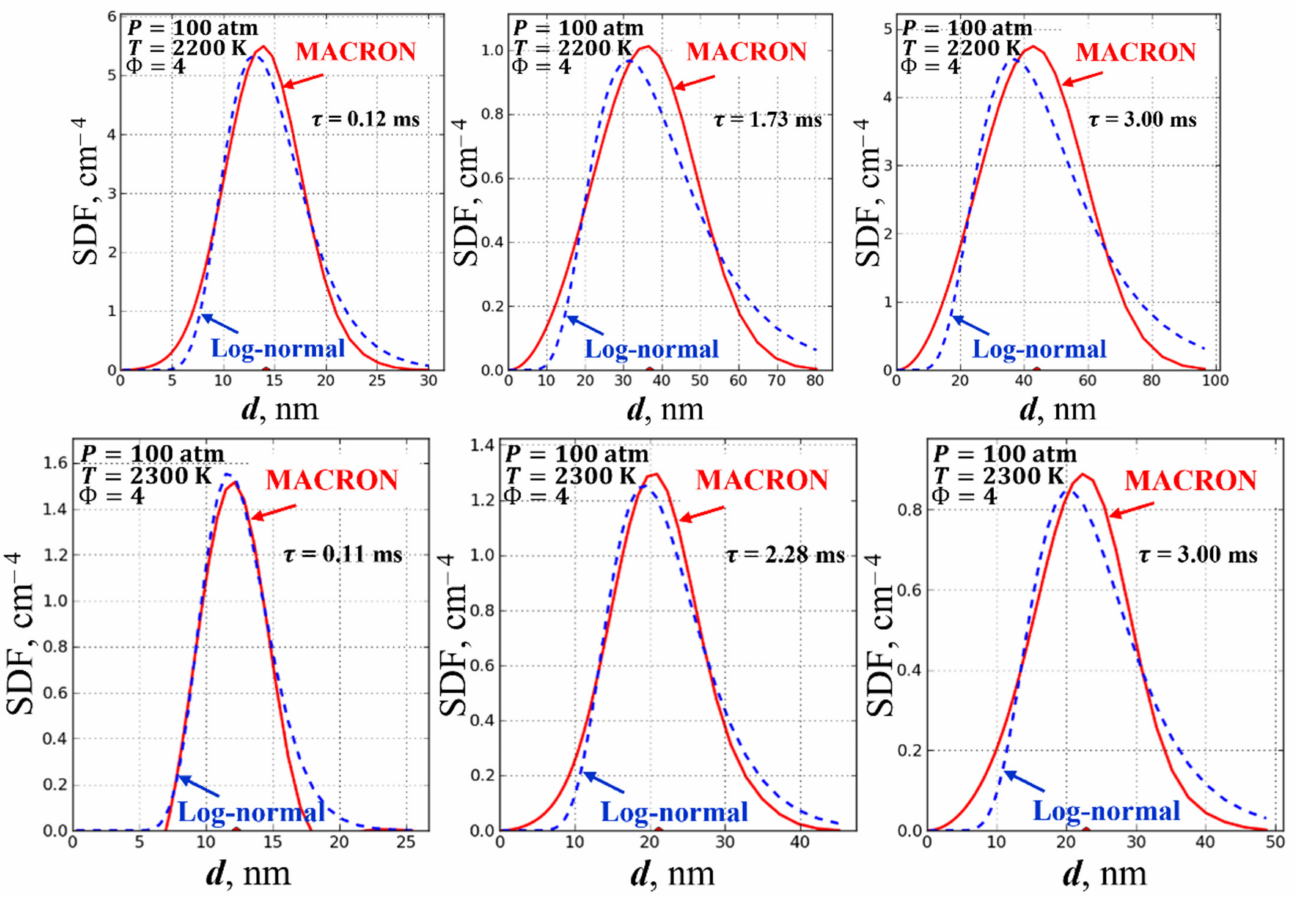
Figure 6. The soot-particle SDF predicted using the MACRON code and its log-normal approximation for n-tetradecane fuel with EGR = 0.6 at some Φ − p − T conditions and time instants from ~0.1 to 3.0